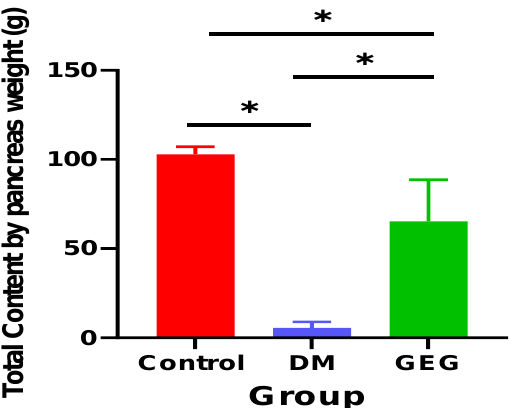
Figure 3. Effect of gingerol-enriched ginger (GEG) on total pancreatic insulin content. Data is expressed as mean ± SEM. n = 6–8 per group. Data was analyzed by one-way ANOVA followed by a post hoc Tukey’s test. * p < 0.05.